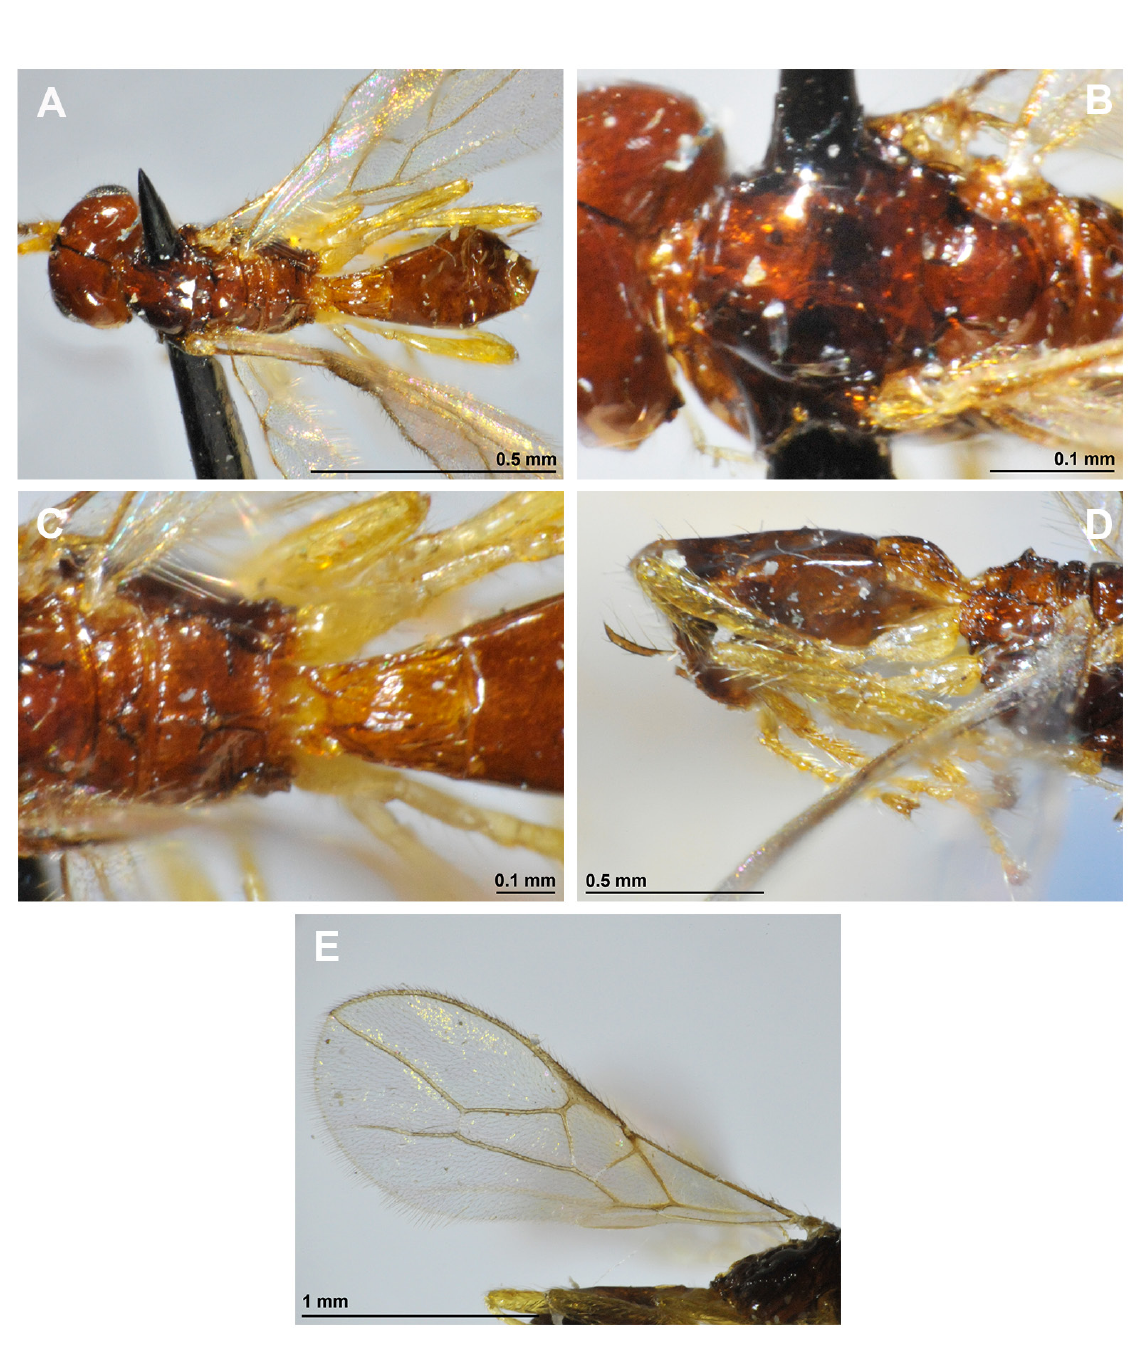
Fig. 61. Asobara subdentata (Granger, 1949), ♀, holotype (MNHN). A . Habitus, dorsal view. B . Mesoscutum, dorsal view. C . Propodeum and first metasomal tergite, dorsal view. D . Hind leg, metasoma and ovipositor, lateral view. E . Fore